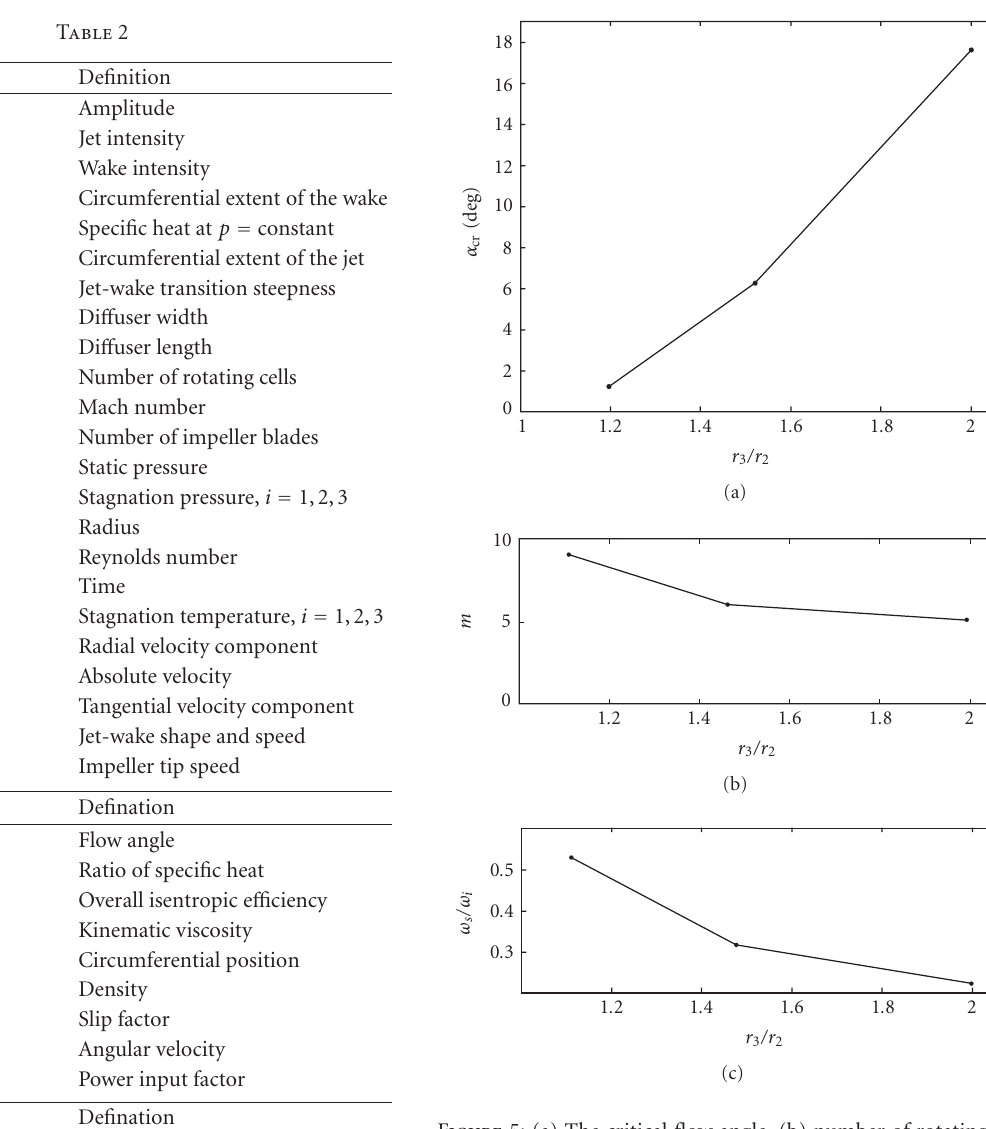
Figure 5: (a) The critical flow angle, (b) number of rotating cells, and (c) their relative propagation speed versus the di ff user radius